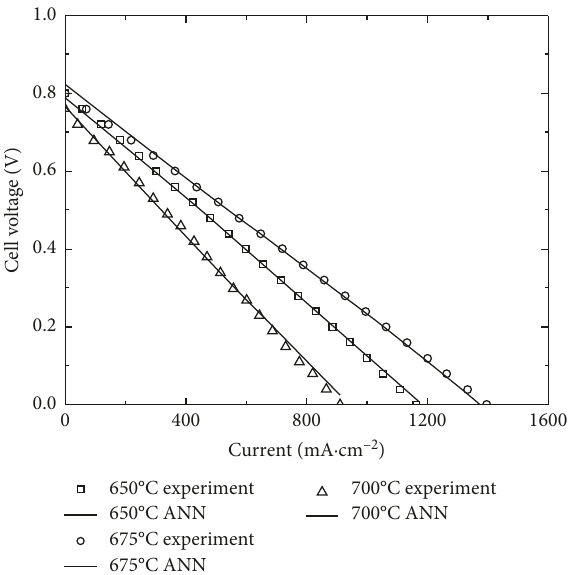
Figure 6: Comparison of I - V curves for the cathode sintered at 1015 ° C and operated at different temperatures by the ANN model and experimental data.